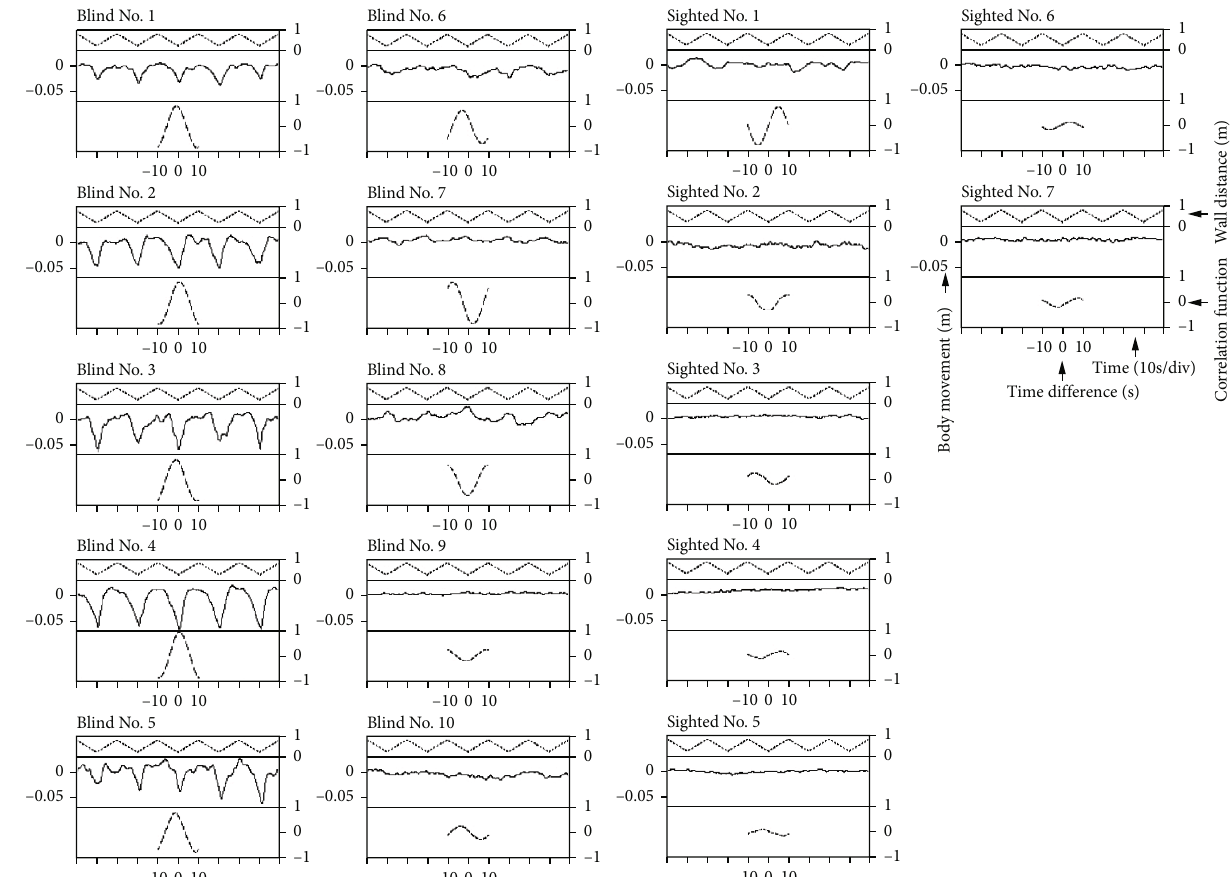
Figure 3: Wall and body movements as functions of time, and the correlation function between the wall and body movements as a function of the time di ff erence. (a, b) The results for the ten blind and seven participants who are sighted, respectively. “ Blind No. ∗ ” and “ Sighted No. ∗ ” at the top-left of each graph show the ID number assigned to each participant. The upper, middle, and lower parts of each graph show the presented wall movements, the measured body movements, and their correlation function, respectively. The scales of the axes are shown in the line second from the top of the rightmost graph. For the body movements, the standing position of the participant is zero, and back direction has a negative